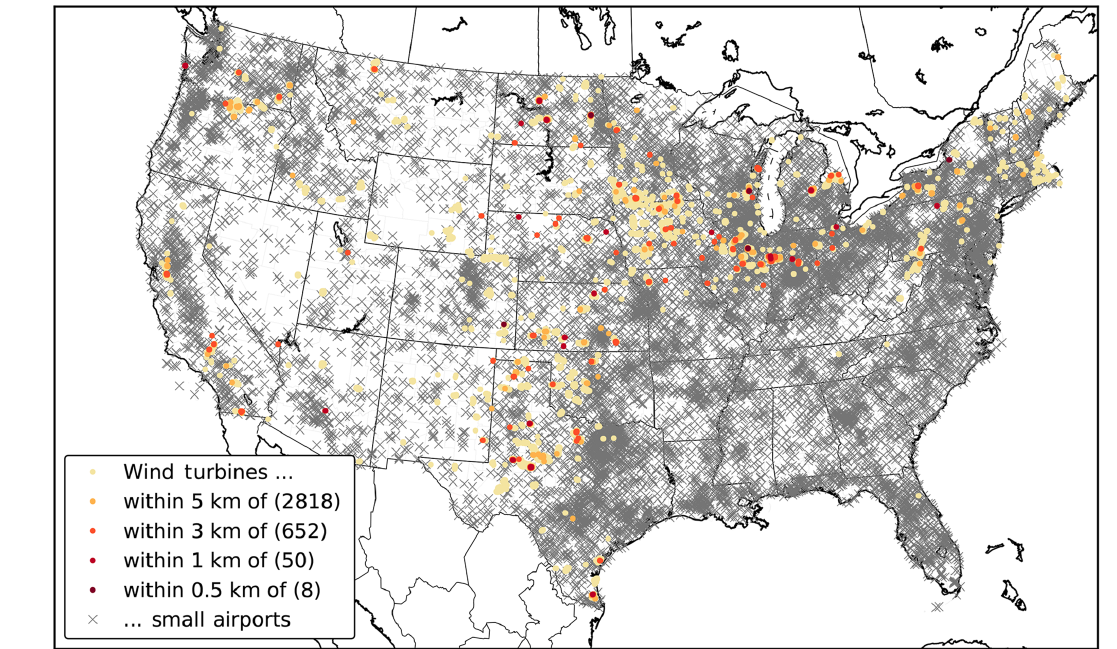
Figure 1. Map of wind turbines (dots) and small airports ( x ) in the continental United States. Turbine dots are colored increasingly red as their proximity to a small airport increases. The number of turbines in each distance range is shown in